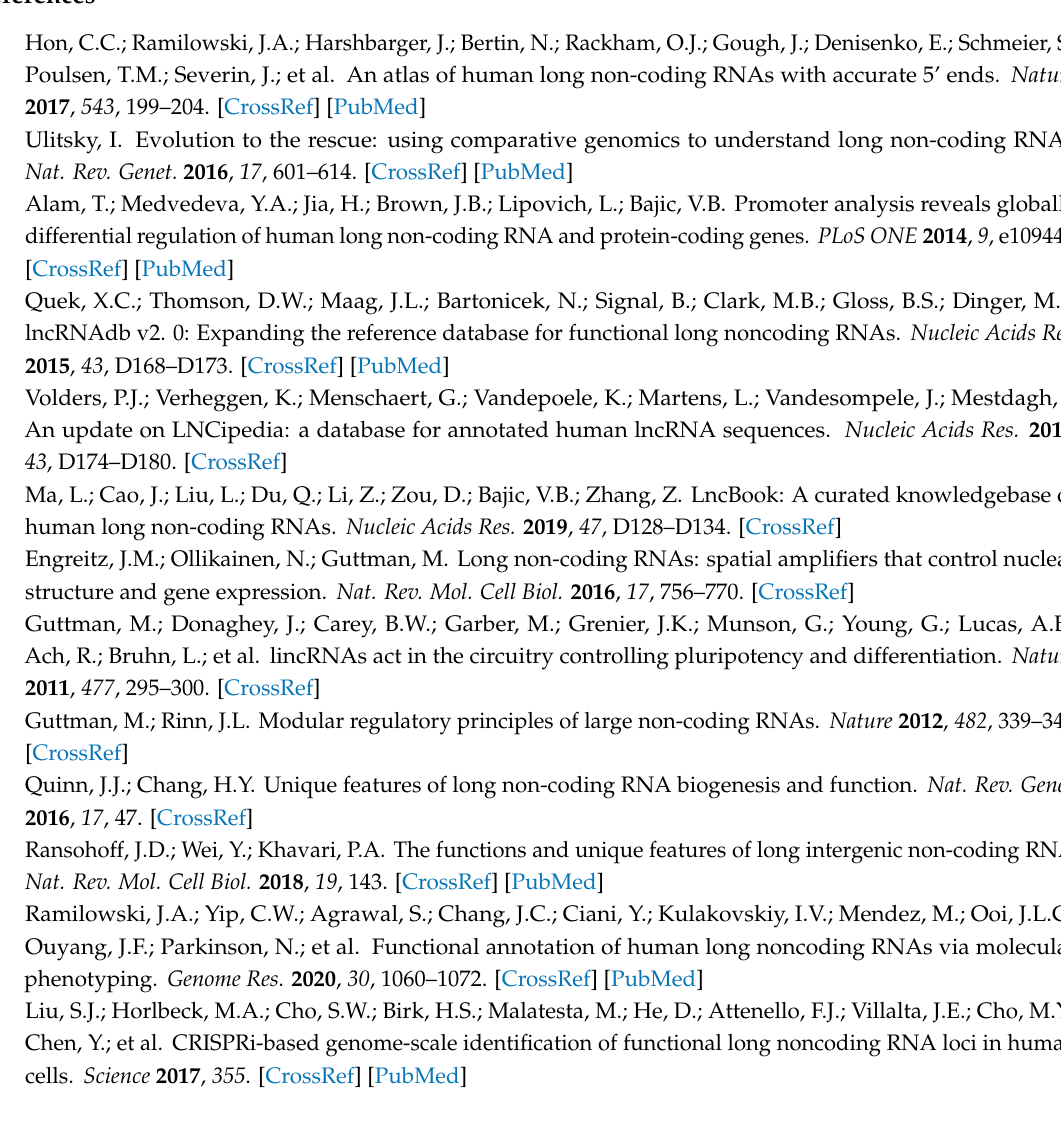
s1. Supplementary Figure S1: Efficiency of all the ASO knockdowns in the FANTOM6 project; Supplementary Figure S2: The overlap between differentially expressed genes identified in two independent knockdown experiments of the CHASSER lncRNA; Supplementary Figure S3: Types of differentially expressed genes in two independent CHASSER knockdown experiments and in Chasser-/- mouse embryonic fibroblases (mEFs); Supplementary Figure S4: Output of the GenometriCorr tool for the two ASOs corresponding to the lncRNA AC013394.2 (CHASERR); Supplementary Figure S5: Pairwise sequence alignment of the human and mouse CHASSER orthologs; Supplementary Data S1: The code and the corresponding data files that were used to generate the images in the